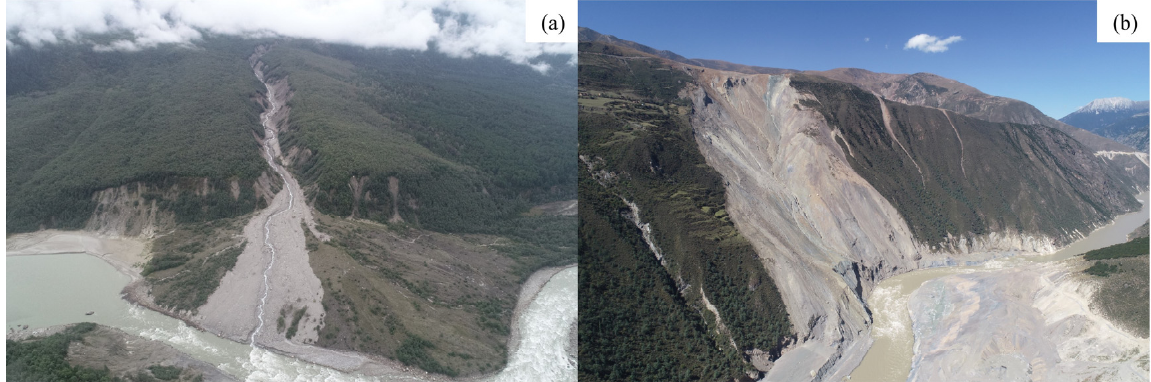
Figure 2. Unmanned aerial vehicle (UAV) images of typical landslides taken in October 2020. ( a ) Yigong landslide. ( b ) Baige landslide.